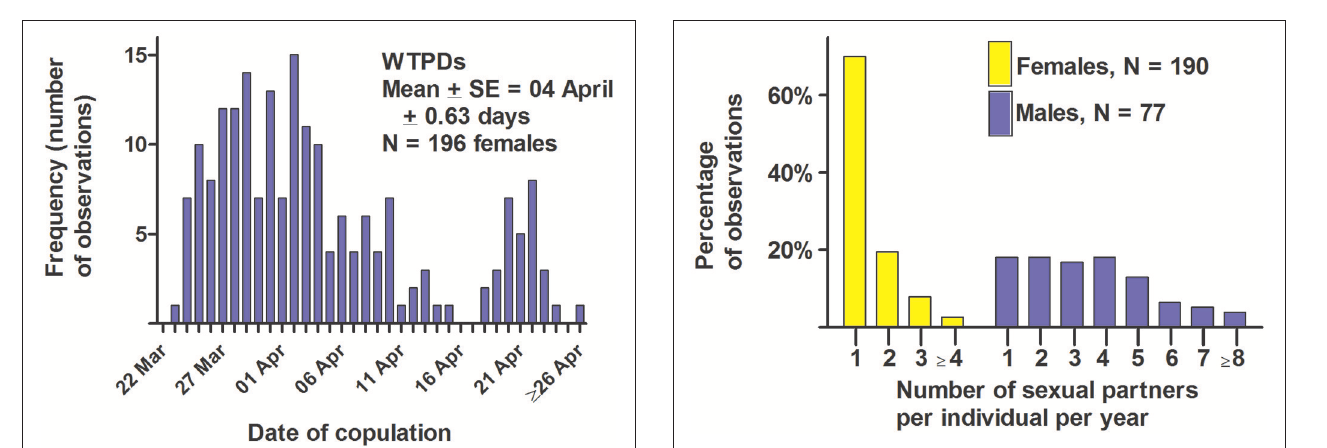
FIGURE 6 | Date of copulation for 196 female white-tailed prairie dogs at the Arapaho National Wildlife Refuge, Colorado USA, from 2006 through 2012. Each female was sexually receptive for only a single day of the mating season each year. Within a year, the mating season (first copulation through last copulation) usually lasted for about 3 weeks.